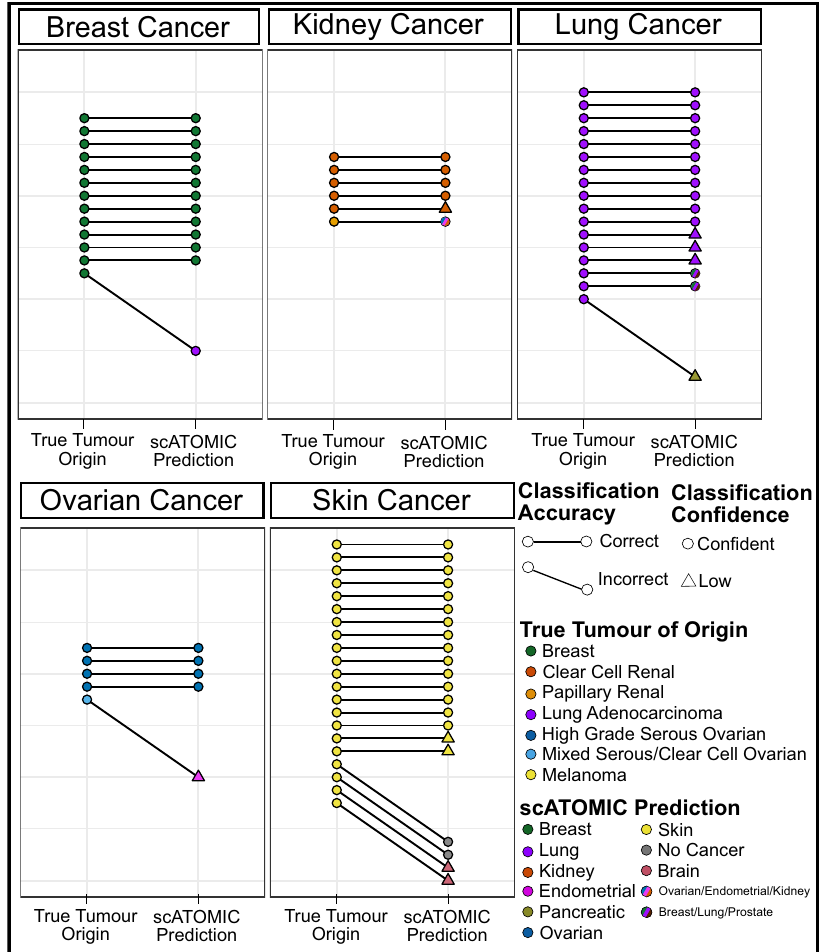
Fig.6|scATOMICaccuratelyidenti fi esthetissueoforigininmetastatictumour biopsies. scATOMIC was applied to 62 metastatic tumours from breast, kidney, lung, ovarian and skin. Metastatic sites included the brain, lungs, GI tract, liver, adrenal glands, lymph nodes, abdomen, and peritoneal cavity. Each pair of dots represents the true tumour origin and the predicted origin. Horizontal connected lines represent correct predictions, while diagonal lines represent incorrect